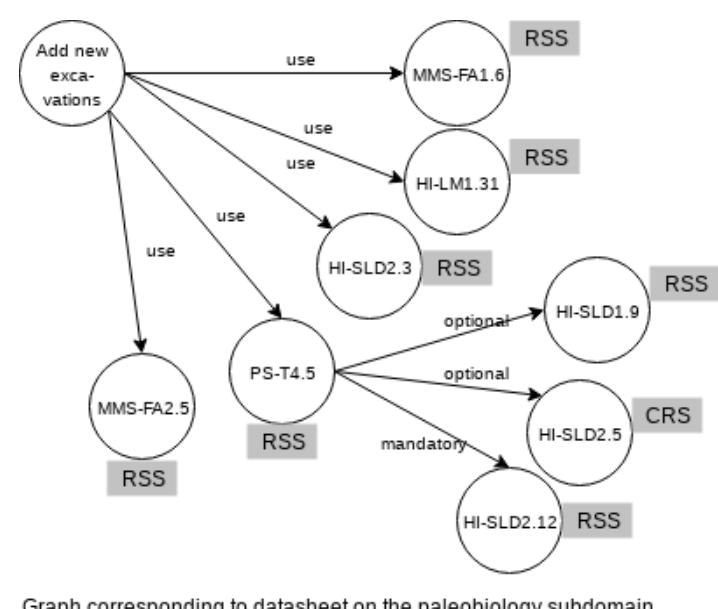
Figure 14. Graph generated from the Add New Excavations datasheet, shown in Figure